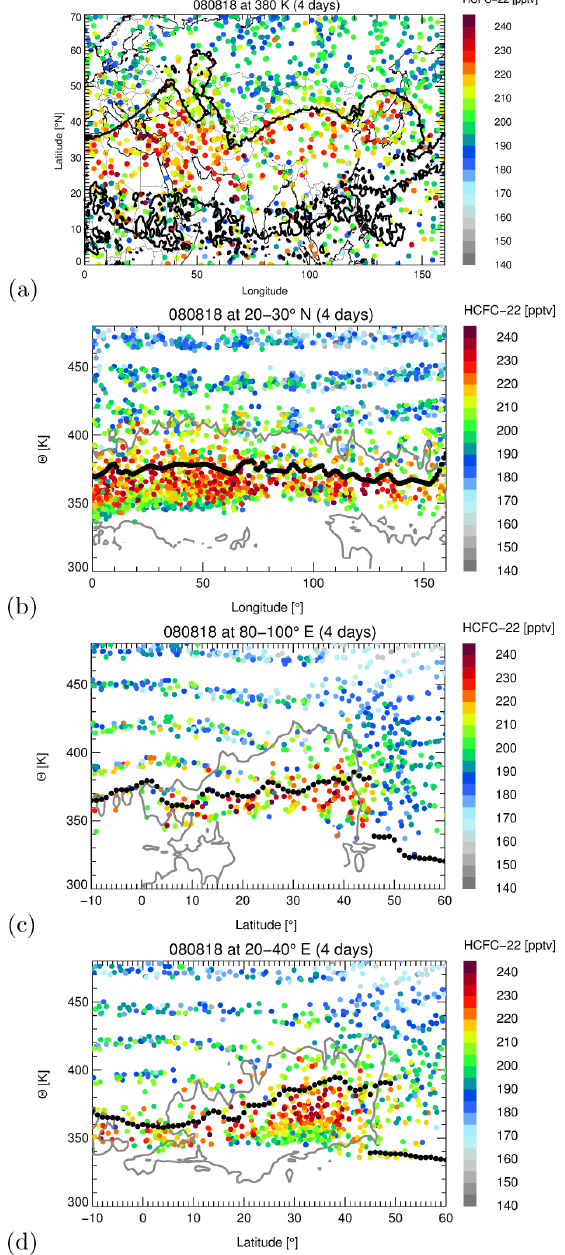
Figure 4. Horizontal distribution of MIPAS HCFC-22 measure- ments at 380K potential temperature (a) . The MIPAS measure- ments are synoptically interpolated within 4 days (for details see Sect. 2.4). Longitude–theta cross section at 25 ◦ N (b) is shown as well as latitude–theta cross sections at 90 ◦ E (eastern part of the an- ticyclone) (c) and at 30 ◦ E (western part of the anticyclone) (d) on 18 August 2008. The contour line of 20% of the India/China tracer is shown by thick black (maps) or grey (cross sections) lines as shown in Figs. 3 and 2. The thermal tropopause is marked by black